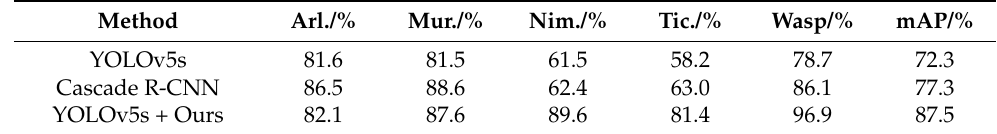
Table 5. Results of direct detection and first detection then classification.